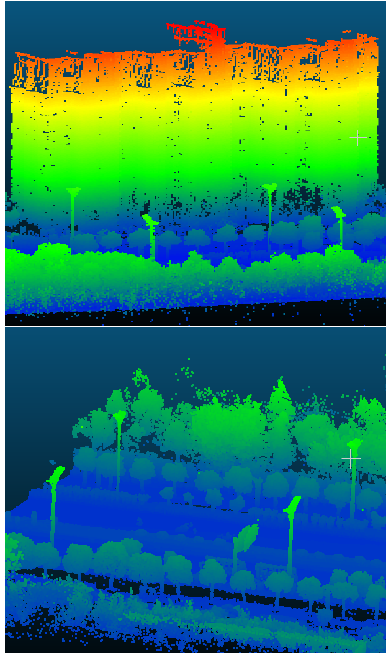
Figure 5. Point cloud colorized by